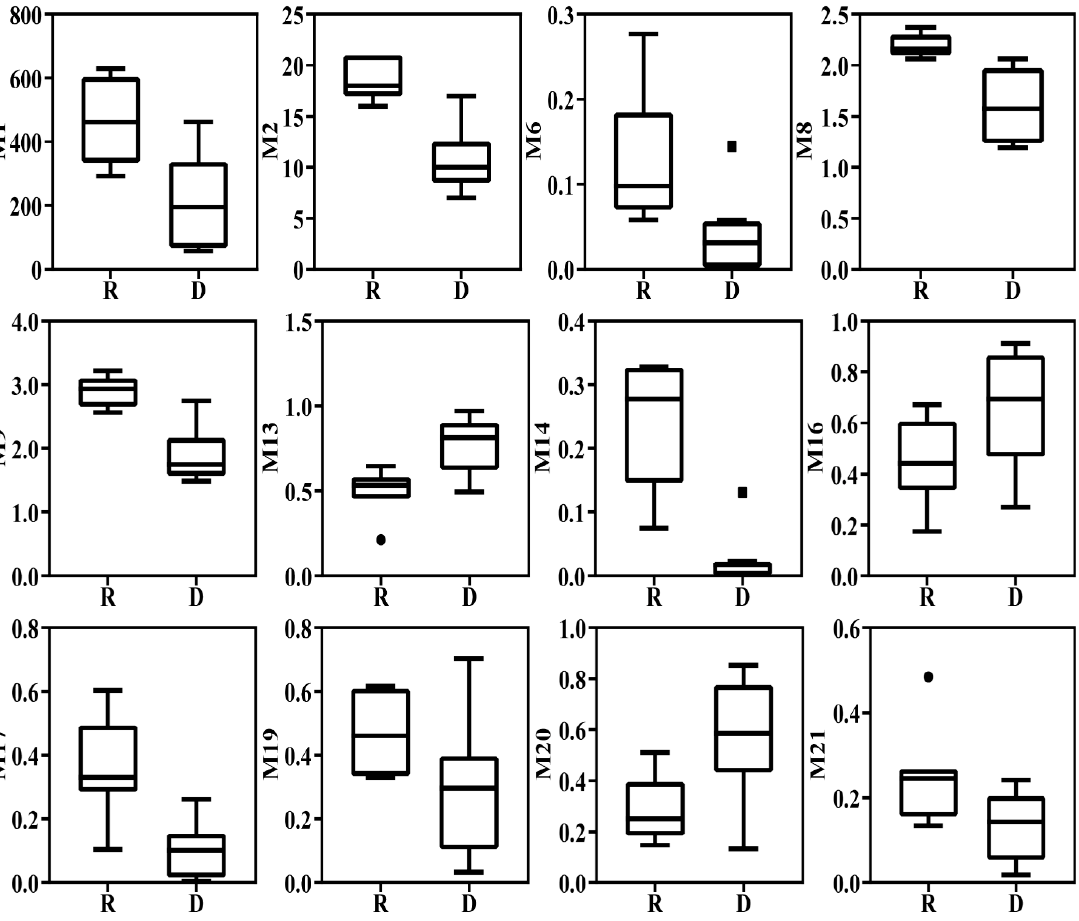
Figure 7. Box plots of the 12 candidate metrics between the reference sites (R) and the disturbed sites (D).